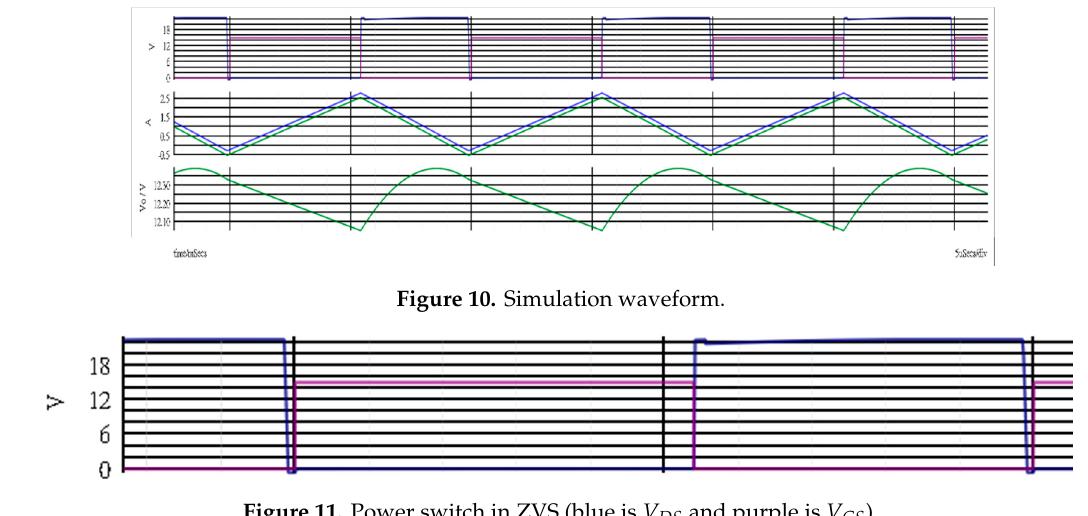
Figure 11. Power switch in ZVS (blue is V DS and purple is V GS ).